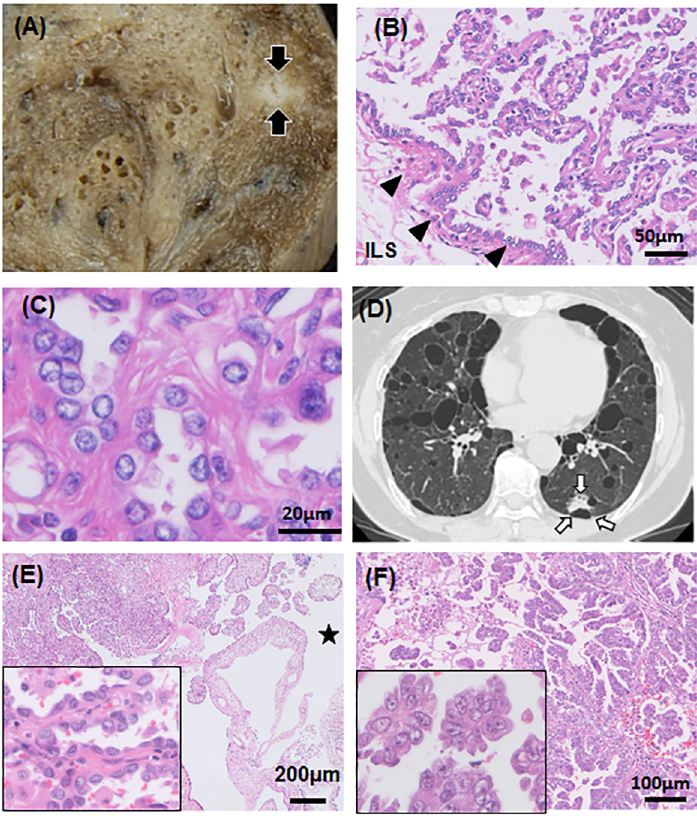
Fig 2. Histological features of a micronodular pneumocyte hyperplasia (MPH)-like lesion and adenocarcinomas. (A) The sectioned surface of LP4-T1 is shown. The arrows indicate the white nodule that corresponds to an MPH-like lesion. (B) Hematoxylin and eosin (HE) staining of the MPH-like lesion. The lesion borders on the interlobular septum (ILS), indicated by arrowheads. (C) Further magnification of the lesion. Plump pneumocytes have enlarged nuclei that lack overt atypia and mitosis. The alveolar septa are thickened with dense fibers. (D) Computed tomography of LP1 demonstrates multiple cysts and a ground- glass opacity lesion indicated by arrows. (E) HE staining of the papillary adenocarcinoma (LP1-T1). A star indicates the cyst infiltrated by cancer cells. Inset: Higher magnification of the lesion. (F) HE staining of the micropapillary adenocarcinoma (LP2-T1). Inset: Higher magnification of the